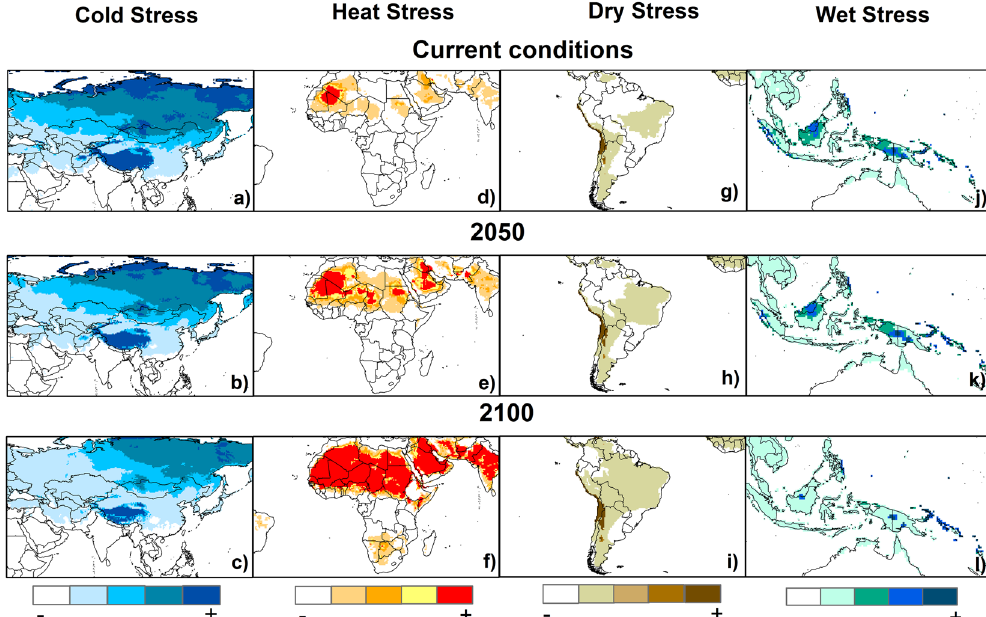
Figure 3. Projections of cold stress in Europe and Asia; ( a ) current scenario, ( b ) 2050, and ( c ) 2100; heat stress in Africa: ( d ) current scenario, ( e ) 2050, and ( f ) 2100; dry stress in South America: ( g ) current scenario, ( h ) 2050, and ( i ) 2100; and wet stress in Southeast Asia: ( j ) current scenario, ( k ) 2050, and ( l ) 2100. ArcMap 10.2 (http://desktop.arcgis.com/en/arcmap).